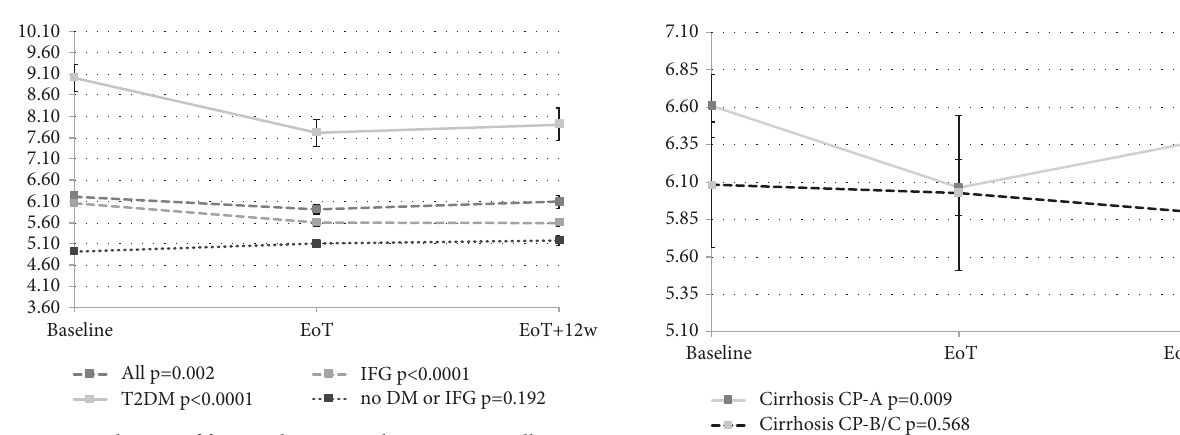
Figure 2: Changes of fasting glycemia with treatment in all patients and subgroups of patients with type 2 diabetes mellitus or impaired fasting glucose. EoT: end of treatment; EoT+12w: 12 weeks after the end of treatment.